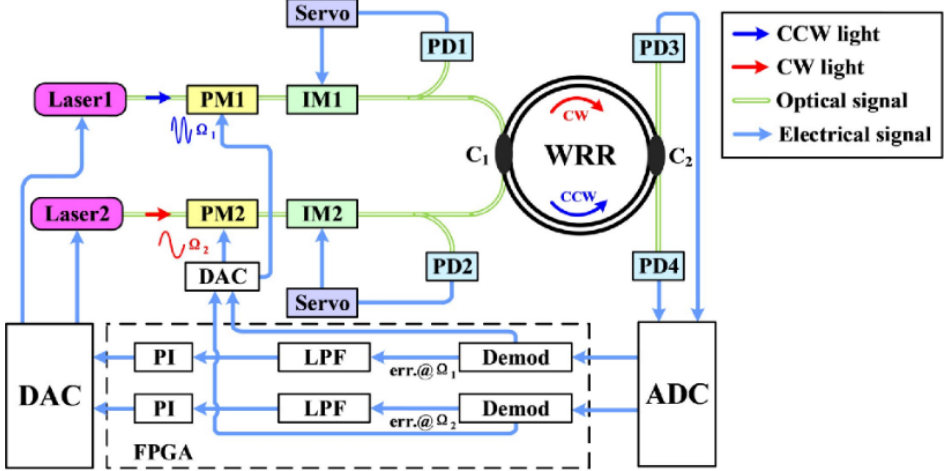
Figure 13. Schematic diagram of the RIOG with two independent lasers. DAC: digital-to-analog converter; FPGA: field programmable gate array; LPF: low-pass filter. Reprinted with permission from ref. [36]. Copyright 2021 The Optical